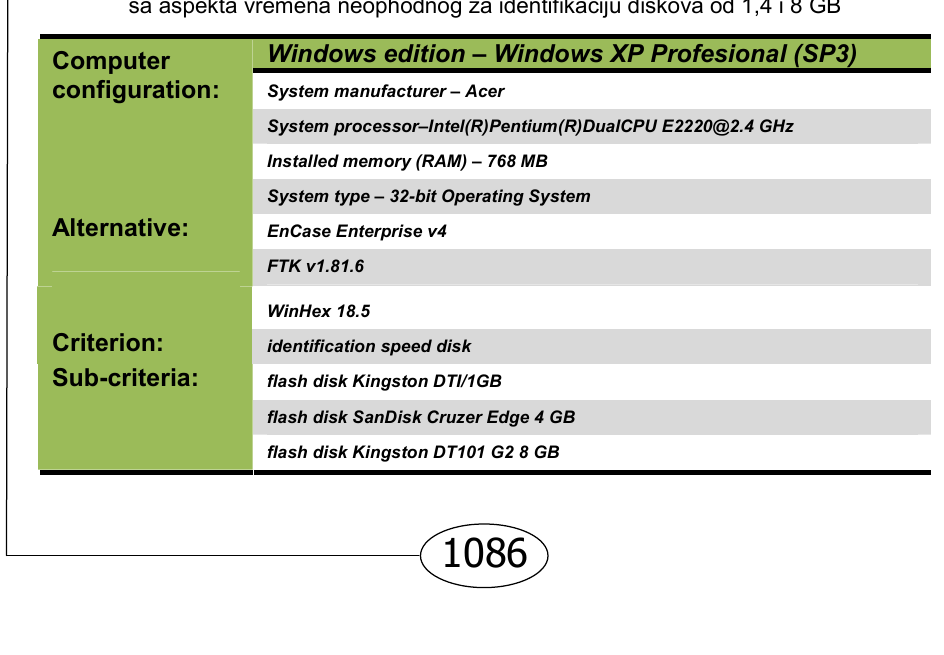
Table 1 – Conditions of testing the digital forensics software: EnCase, FTK and WinHex, in terms of the time required to identify disks of 1, 4 and 8 GB Таблица 1 – Условия , в которых испытаны программные обеспечения